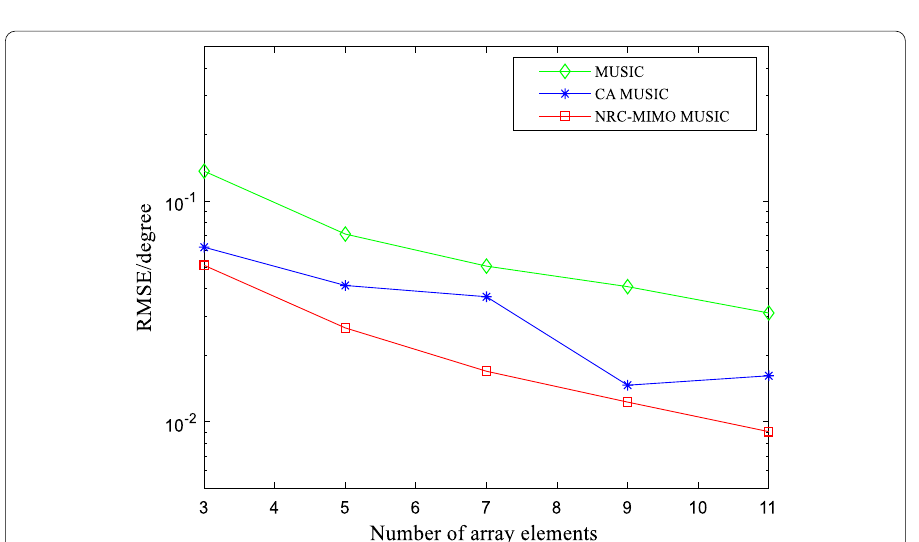
Fig. 8 Relationship between the estimation accuracy and the number of array